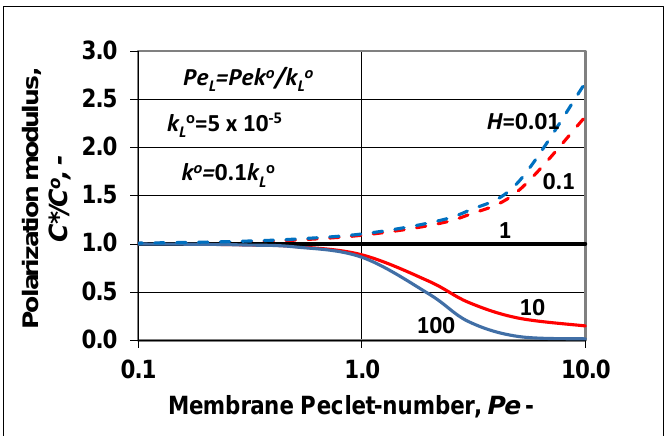
Figure 7. Polarization modulus as a function of the membrane Peclet number, calculated by Equation (36), at different values of the solubility coefficient, H . Values of the mass transfer coefficient and of the Pe L of the polarization layer are the same as in Figure 6, namely ( Pe L = Pek o / k o k o = 5 × 10 − 5 m/s; k o = 0.1 k o L L